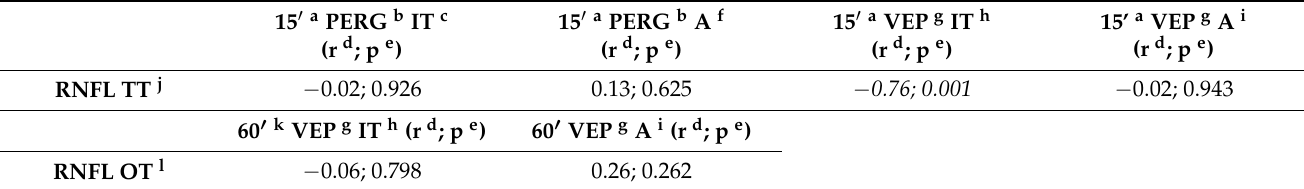
Table 4. Correlation between the morphological and functional values of retinal ganglion cells and optic nerve in carriers of Friedreich’s ataxia